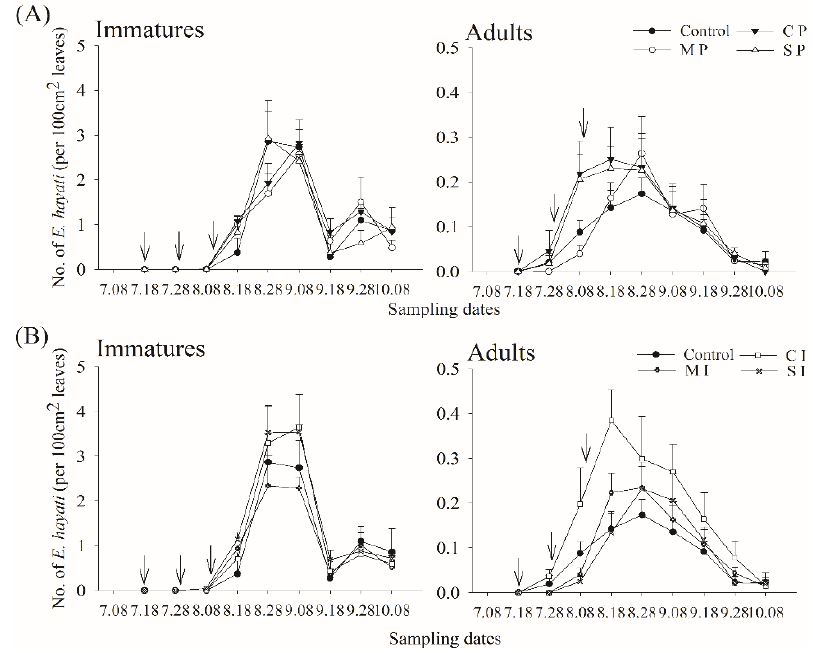
Figure 3. Seasonal dynamics of Eretmocerus hayati (mean + SE) on cotton with perimeter- ( A ) or intercropped ( B ) maize, cantaloupe, and sunflower at Langfang, Hebei Province, northern China, in 2012. In upper of the figures ‘ ↓ ’ means E. hayati had released in this date in the fields.